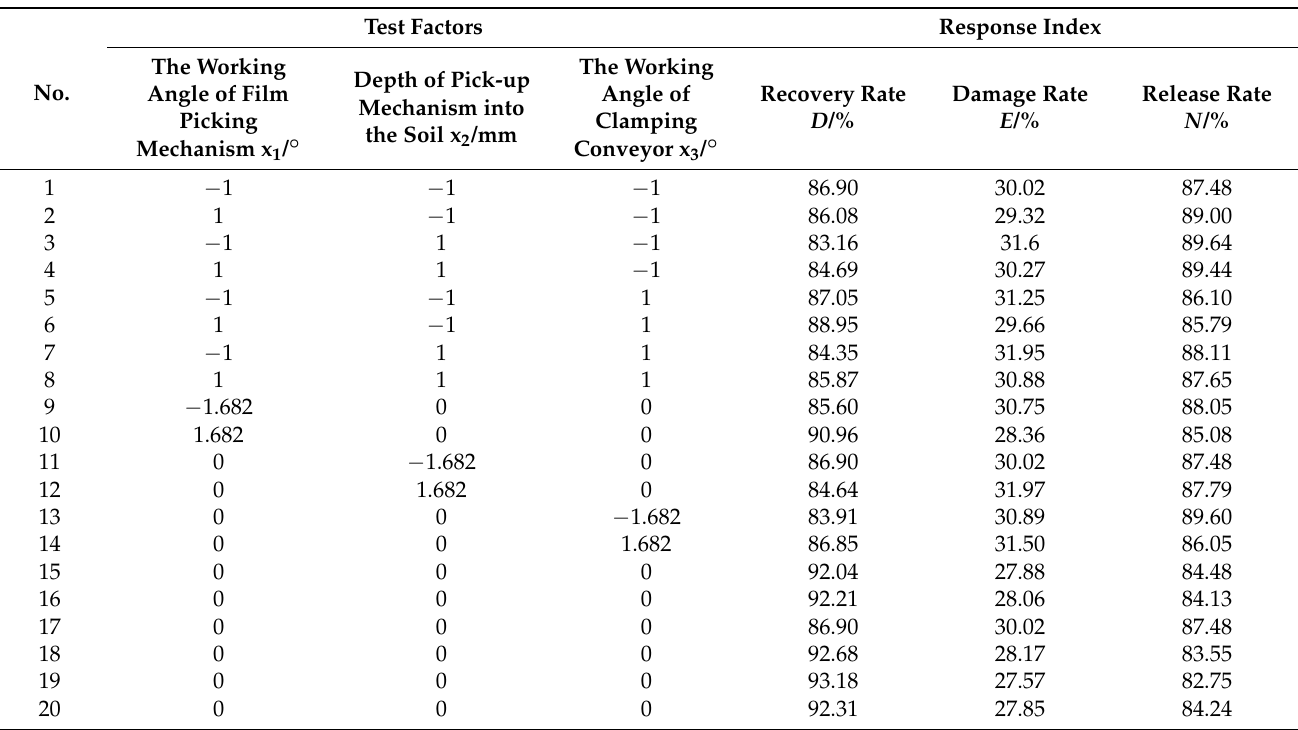
Table 4. Test plan and